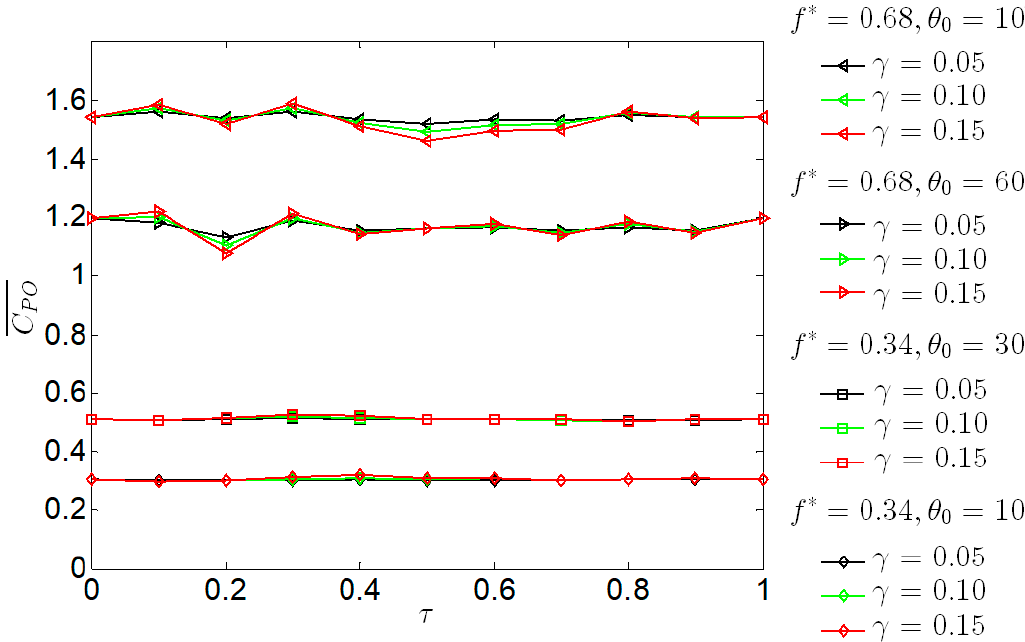
Figure 6. The evolution of the mean propulsion power coefficient with different oscillating amplitude and oscillating frequency coefficient for one period.